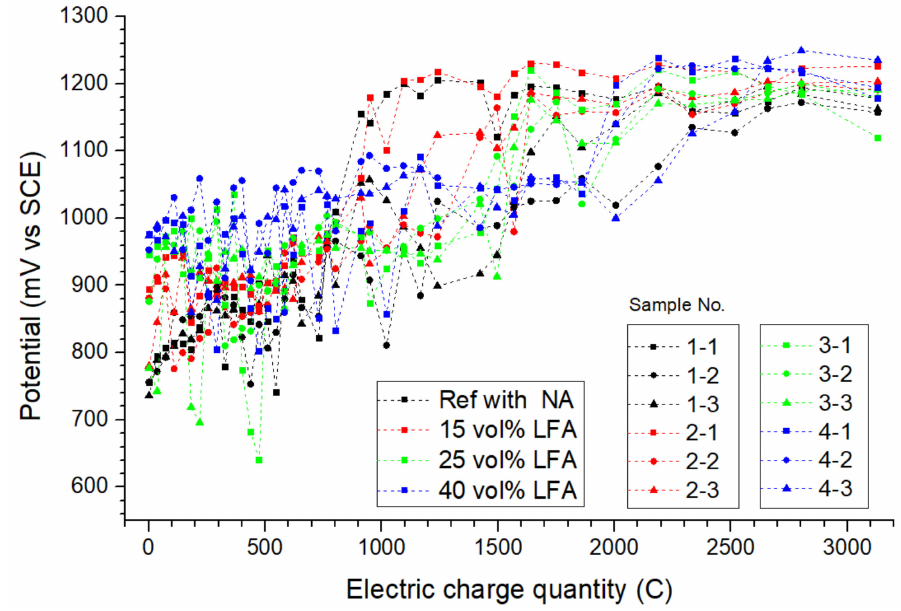
Figure 4. The monitored anode on potential in all simulated ICCP testing